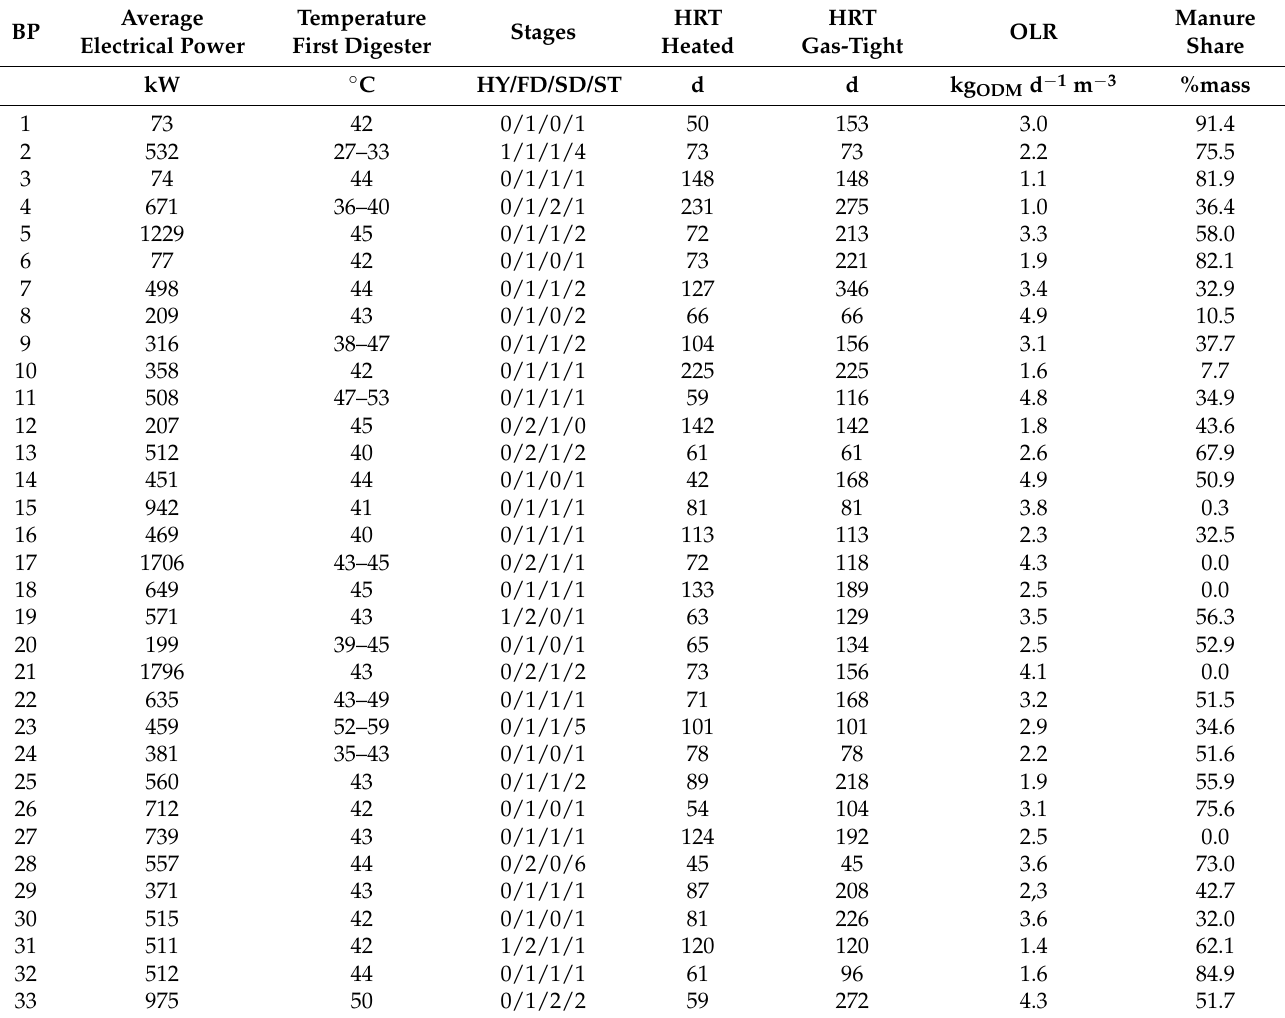
Table 1. Average electrical power production, temperature of the first digester, number of hydrolysis stages (HY), primary digesters (FD), secondary digesters (SD) and storage tanks (ST), hydraulic retention time (HRT), organic loading rate (OLR), manure share of the 33 investigated biogas plants (BP). BP 12 is a research biogas plant with high measurement